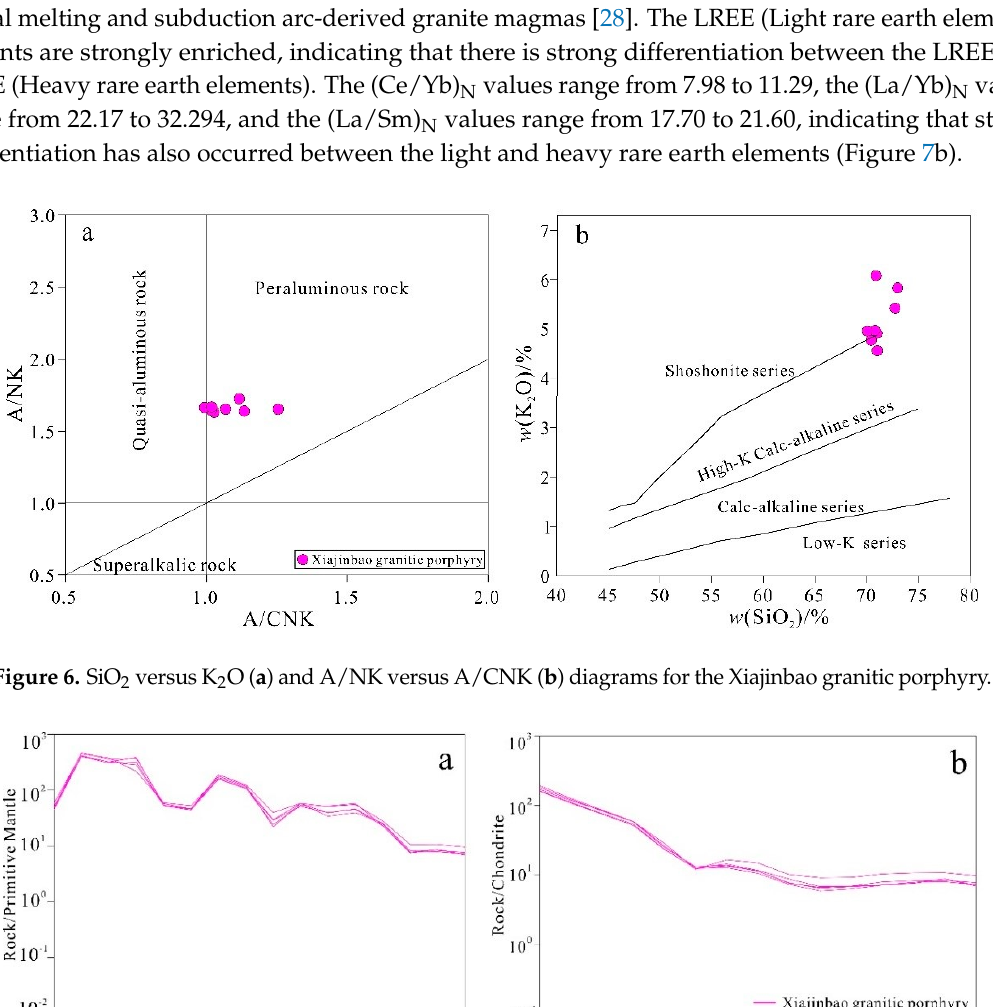
Figure 7. Primitive mantle-normalized trace element patterns ( a ) and Chondrite-normalized REE patterns ( b ) of the Xiajinbao granite.